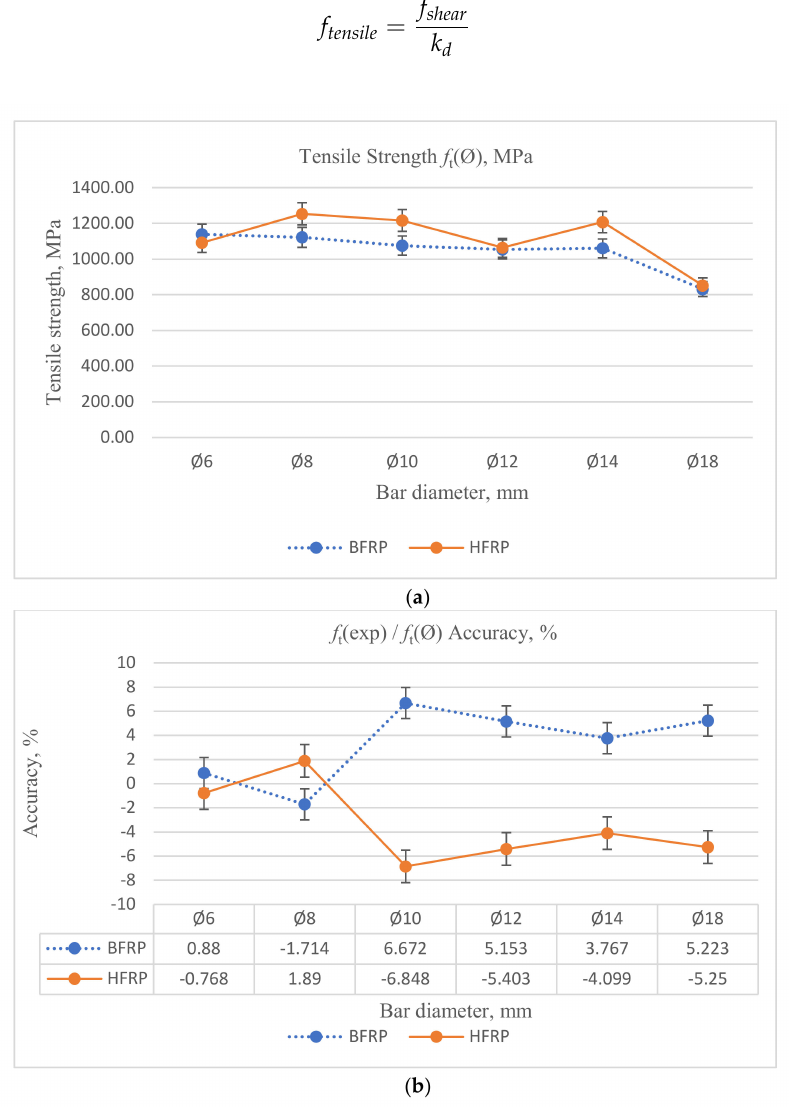
Figure 9. ( a ) Tensile strength obtained theoretically. ( b ) Accuracy according to coe ffi cient ( k d